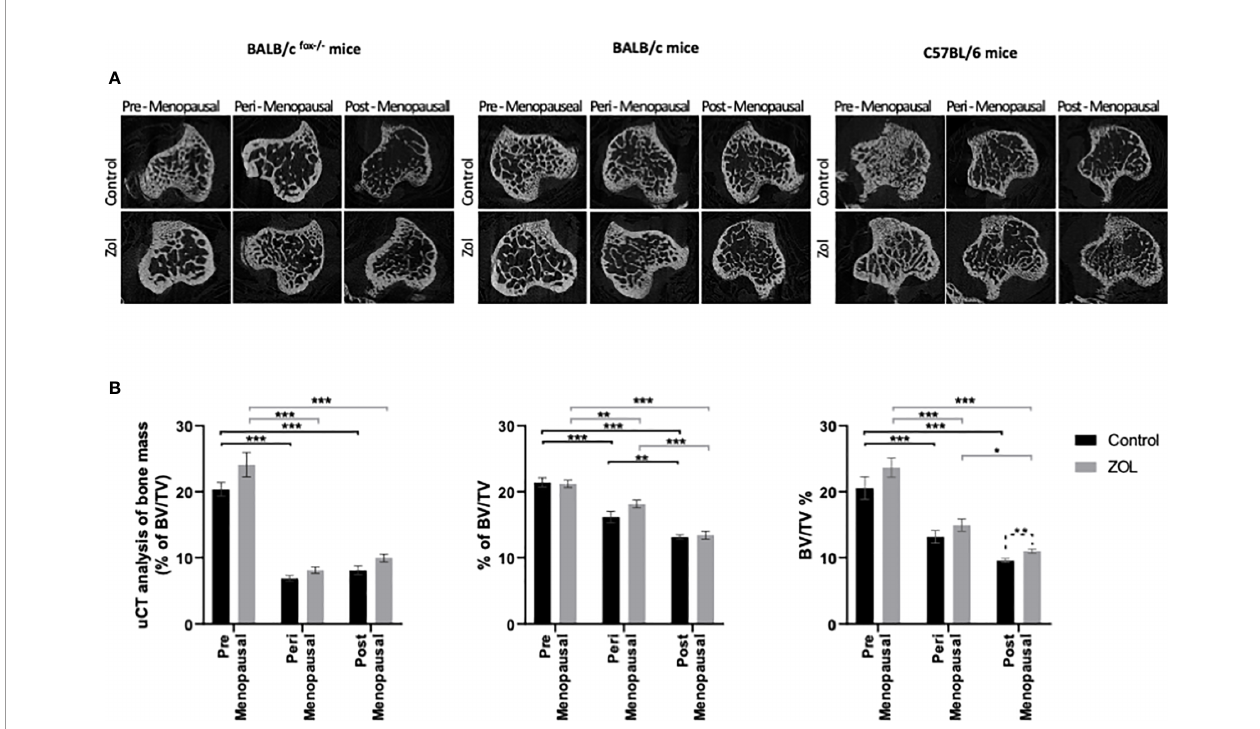
FIGURE 6 | Effects of zoledronic acid on trabecular bone volume in mice supplemented with pre-, post-, and peri-menopausal concentrations of oestradiol following injection of tumour cells. Radiographs show cross-sectional m CT images of trabecular bone (A) . Histograms show mean ± SD percentage of trabecular bone volume compared with tissue volume (BV/TV%) (B) in BALB/c fox/- mice injected with MDA-MB-231 cells, BALB/c mice injected with 4T1 cells, and C57BL/6 mice injected with E0771 cells (n = 10/group). Cell lines were disseminated directly into the bloodstream of the mouse via intracardiac injection 3, 6, and 7 days after induction of pre-, peri-, or post-menopausal concentrations of oestradiol in BALB/c nude, BALB/c, and C57BL/6, respectively, and 3 days after fi rst injection of zoledronic acid. Zoledronic acid was administered weekly at a dose of 100 m g/kg, and all mice received daily injection of goserelin (40 m g/kg). Statistical signi fi cance is represented as *p < 0.05, **p < 0.01, and ***p <